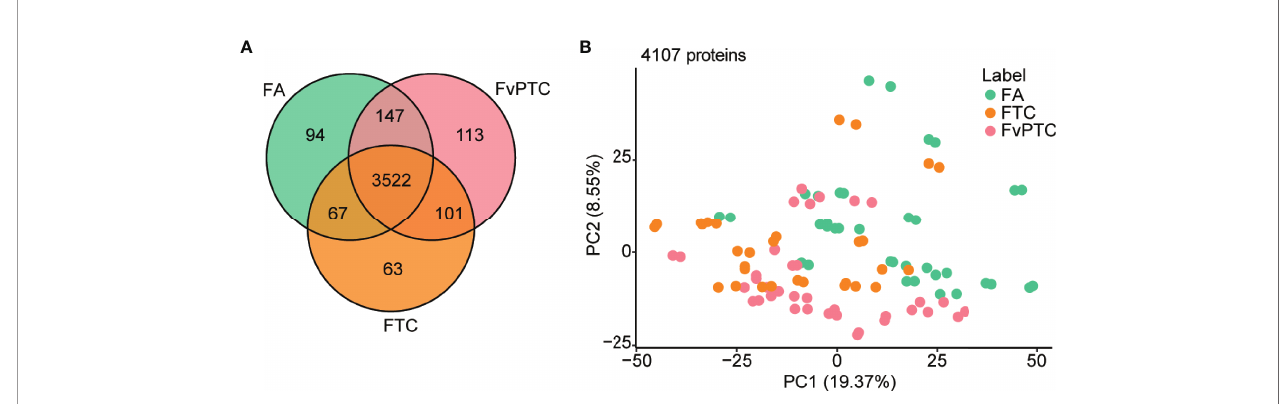
FIGURE 2 | Global proteomic analysis. (A) Venn diagram showing protein identi fi cation in FA, FTC, and FvPTC. (B) Principal component analysis (PCA) using 4107 proteins grouped by